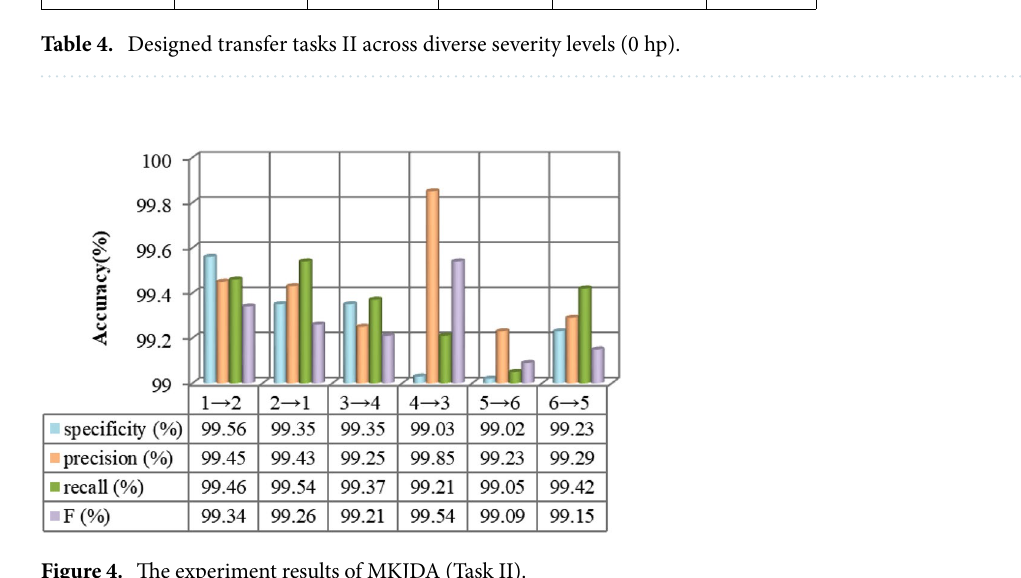
Figure 4. The experiment results of MKJDA (Task